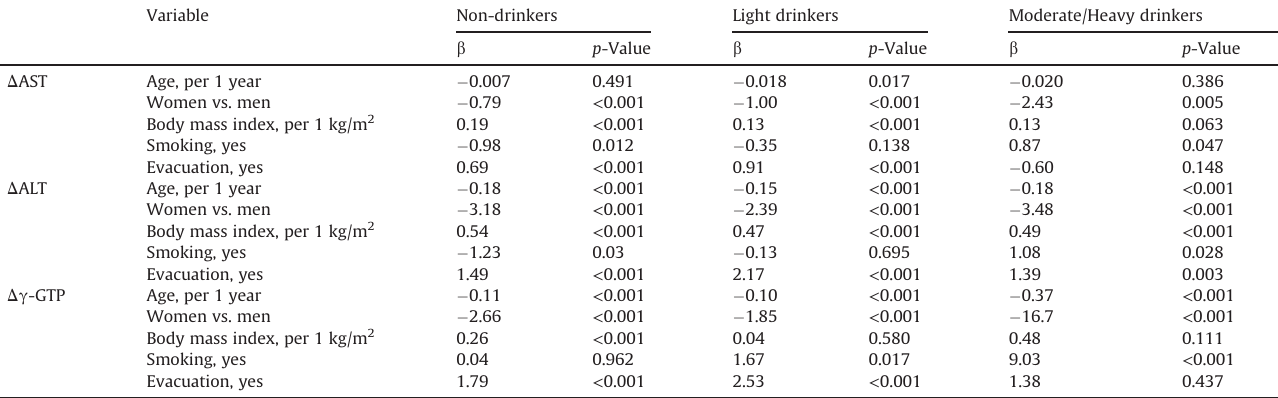
Table 4 Associations of changes in AST, ALT, or g -GTP and factors among 26,006 participants after the Great East Japan Earthquake.